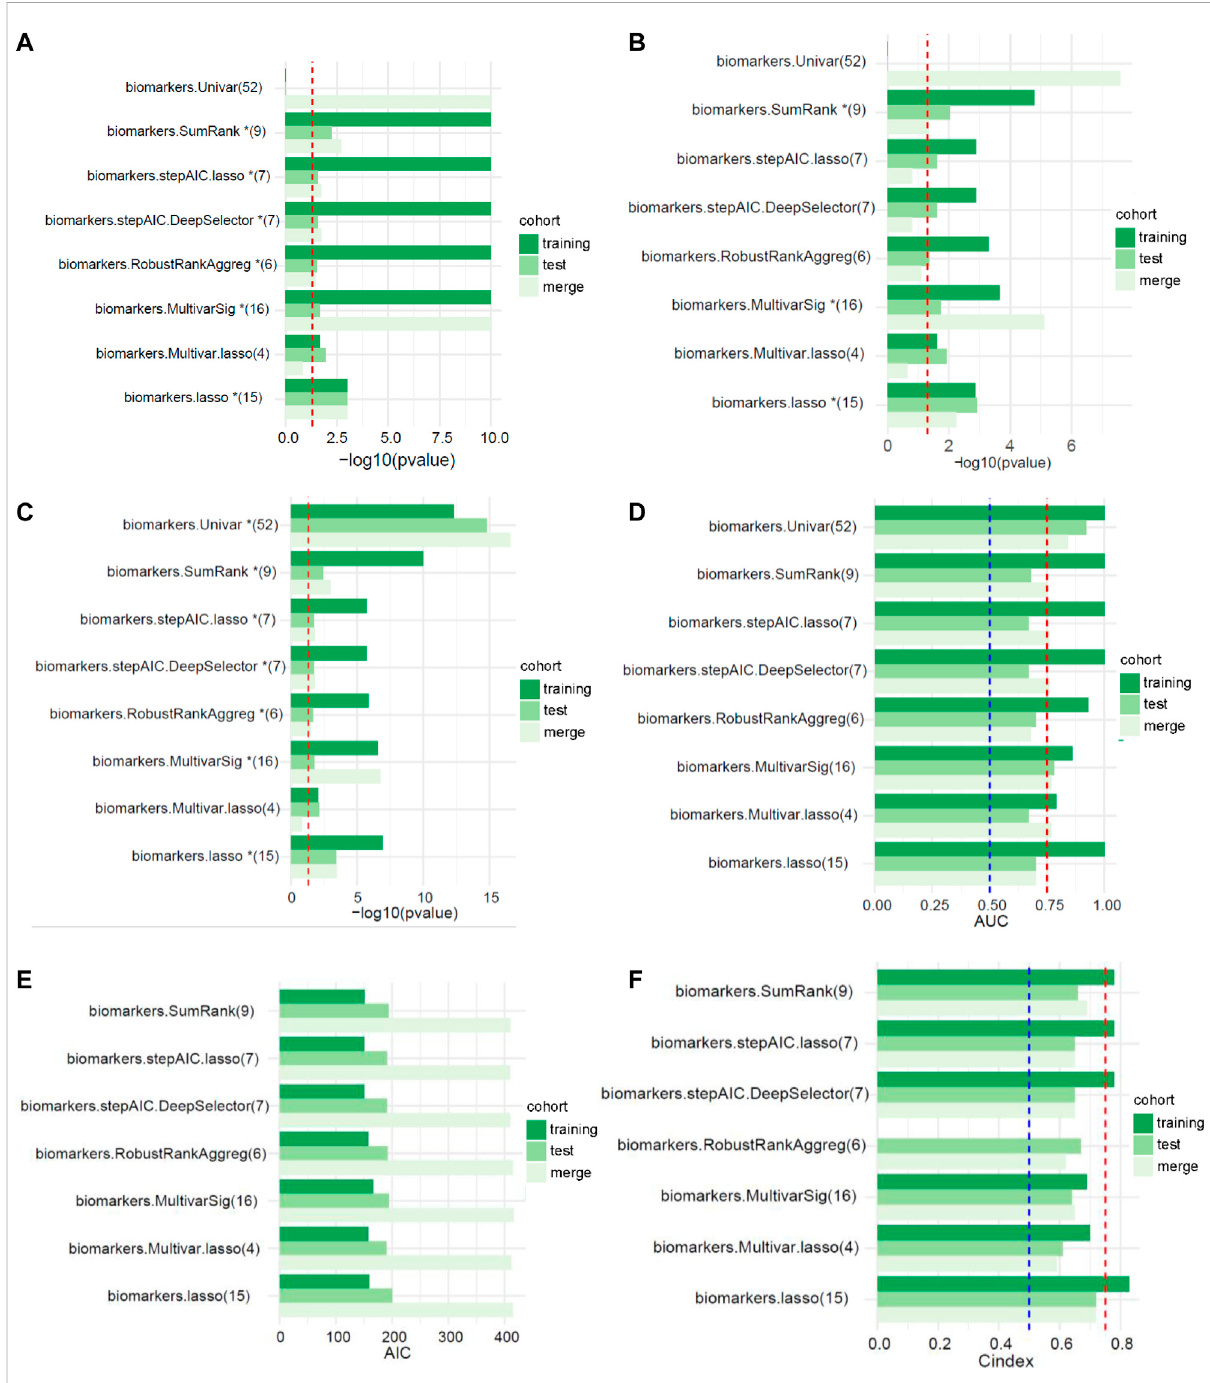
FIGURE 2 Theperformancesofdifferentsignaturesselectedusingmultiplefeatureselectionmethods(thenumbersinparenthesesrepresentthenumber oflncRNAsinthesignature). (A) Univariateanalysis(thereddottedlinerepresents p < 0.05). (B) Multivariateanalysis(thereddottedlinerepresents p < 0.05). (C) Kaplan-Meier survival curve (the red dotted line represents p < 0.05). (D) AUC values of the ROC curves (the red and blue dotted lines represent 0.75 and 0.5, respectively). (E) Akaike ’ s information criterion (AIC). (F) C-index of the logistic regression model (the red and blue dotted lines represent 0.75 and 0.5,